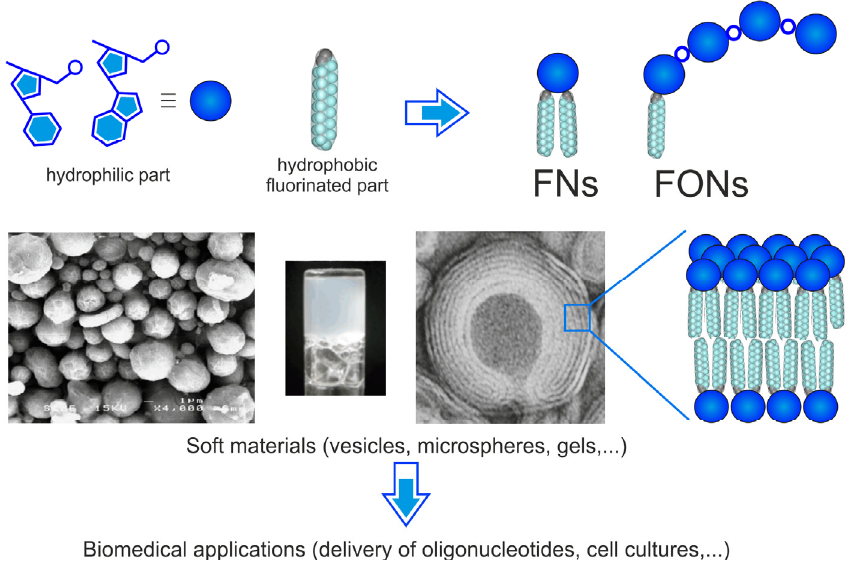
Figure 1. Nucleic Acids Fluorocarbon Amphiphiles (NAFAs), including Fluorocarbon Nucleoside and OligoNucleotide amphiphiles (FNs and FONs, respectively): building blocks for soft materials and biomedical